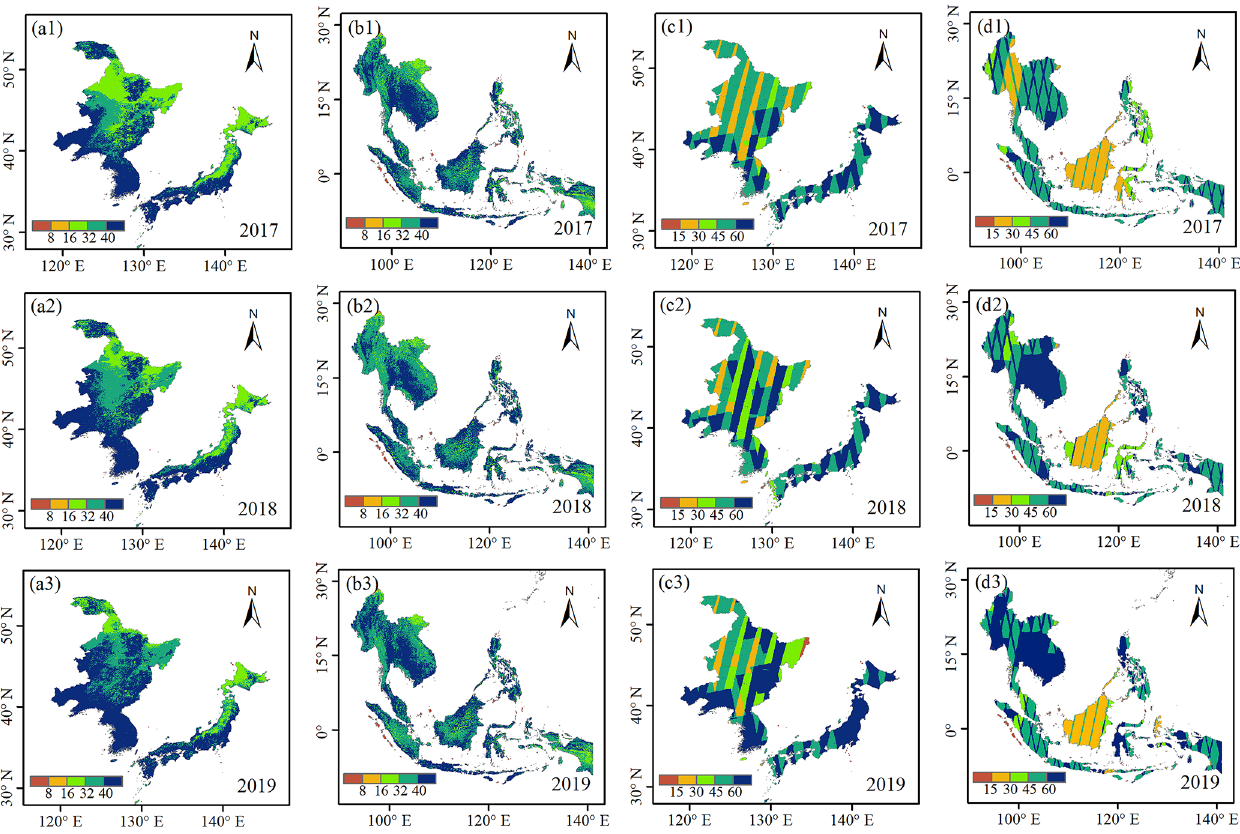
Figure 11. Spatial distribution map of good-quality observation numbers during 2017 to 2019 for (a1–a3) MODIS images in Northeast Asia, (b1–b3) MODIS images in Southeast Asia, (c1–c3) Sentinel-1 images in Northeast Asia, and (d1–d3) Sentinel-1 images in Southeast Asia.